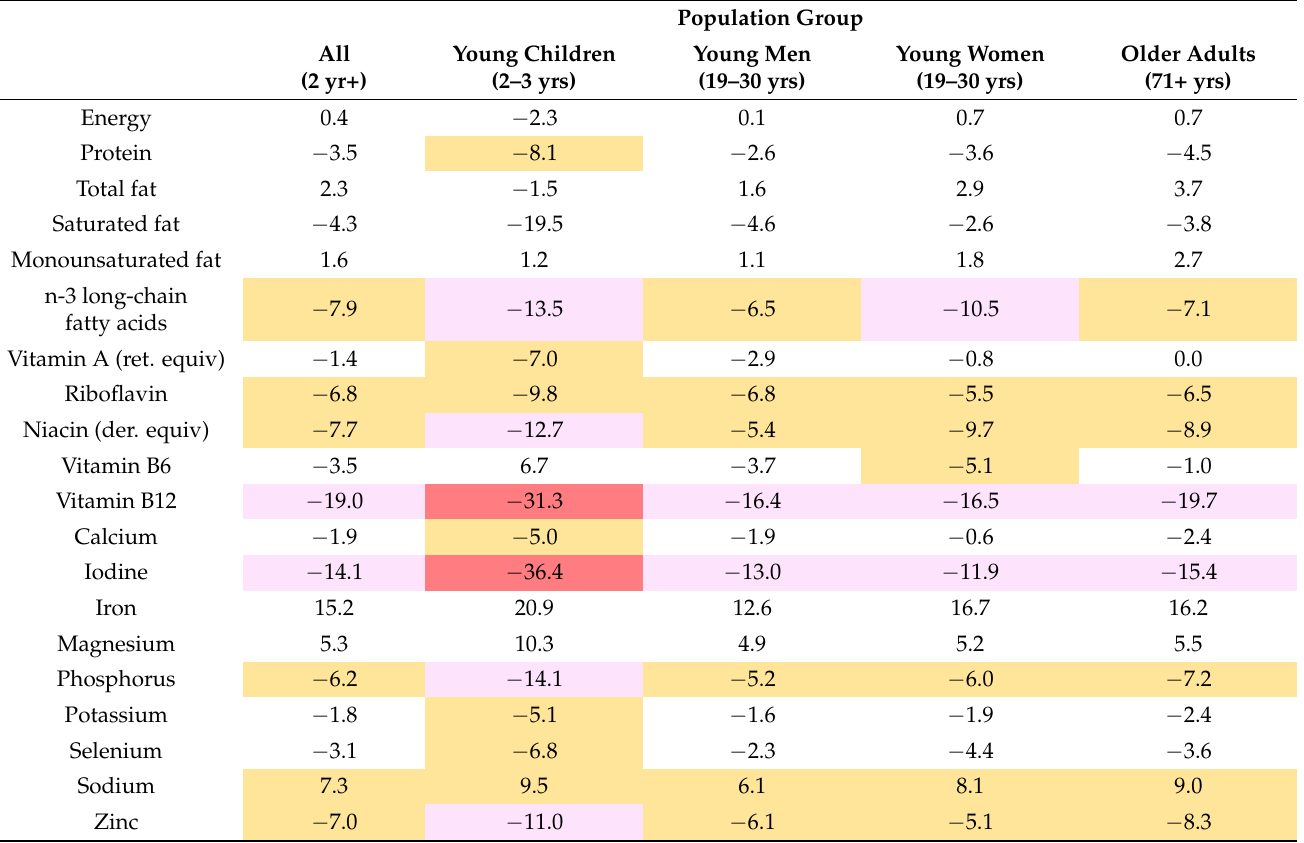
Table 3. Estimated percentage change 1 in mean daily intake of key nutrients if ≈ 42 g per person per day of ‘Easily Swappable Animal-Source Meat’ and all ‘Easily Swapable’ Dairy Milk is replaced with plant-based ‘meat’ and ‘milk’ (Accelerated Combined Meat and Milk